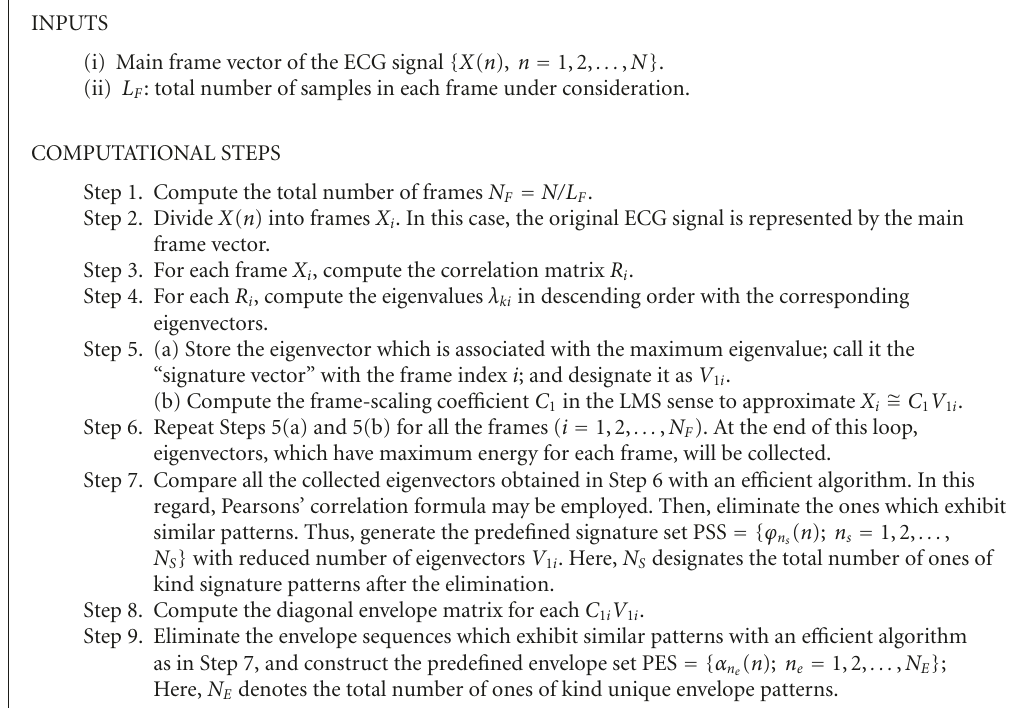
Algorithm 1: Generation of the predefined signature and envelope sets.